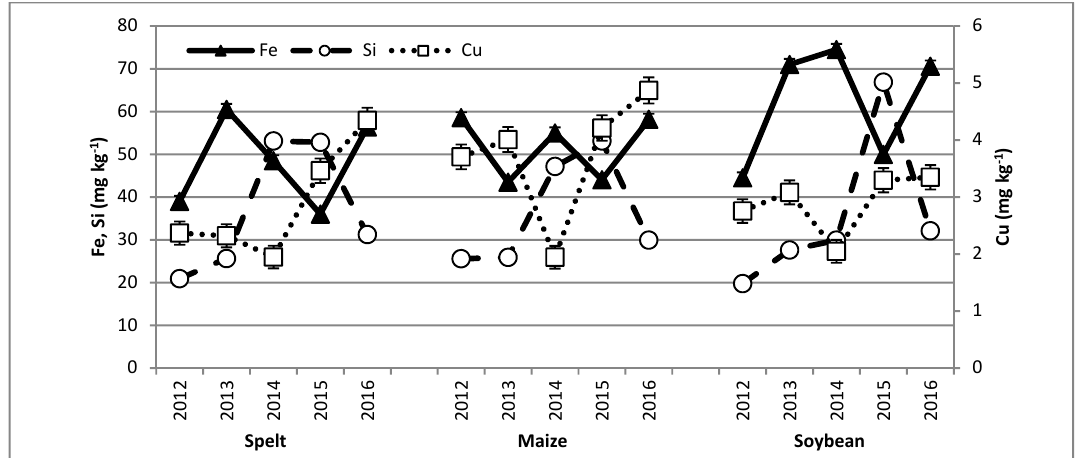
Figure 4. The status of available Fe, Si, and Cu in soil, across seasons, under organic production (bars represent SD values).